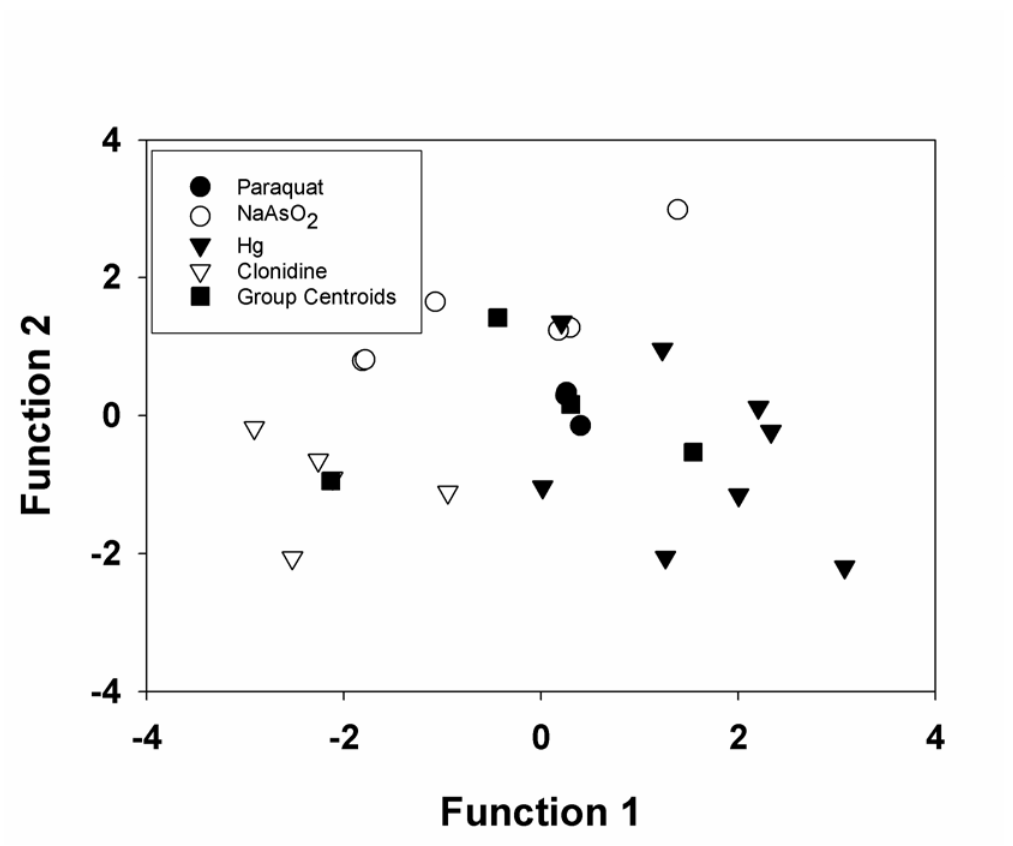
Figure 4. Classification results for combined algal and chromatophore